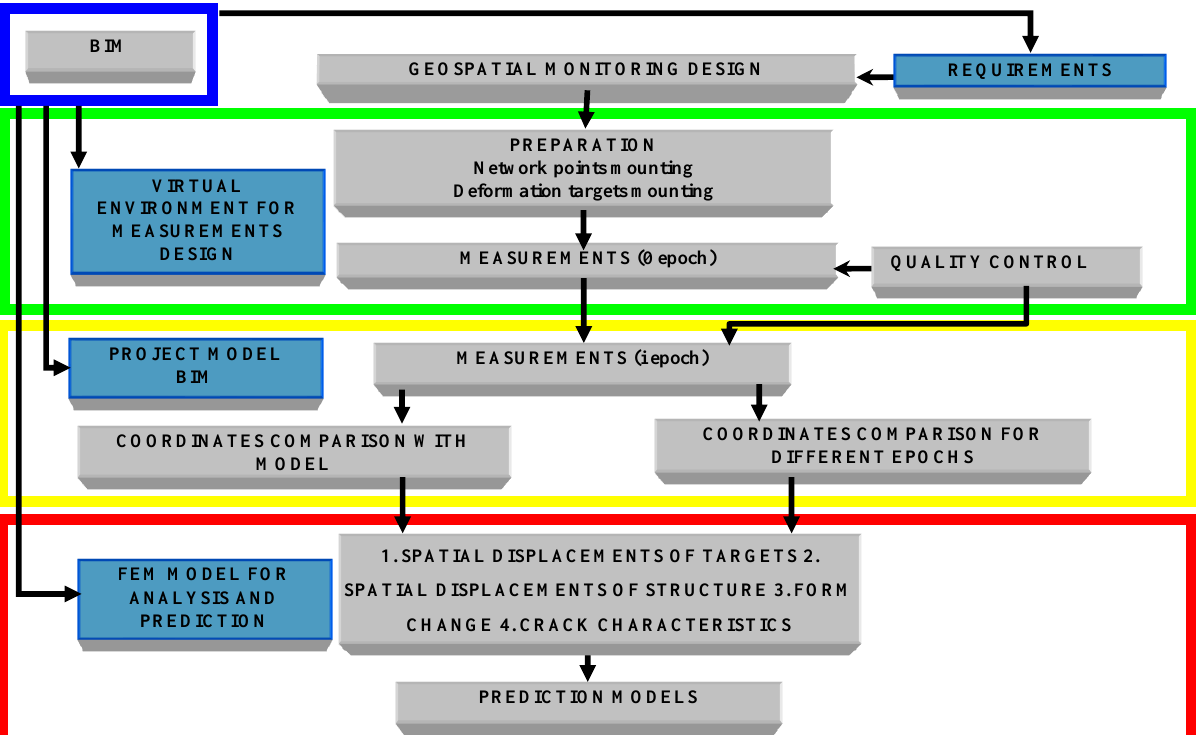
Figure 3 . Workflow scheme of geospatial monitoring with BIM